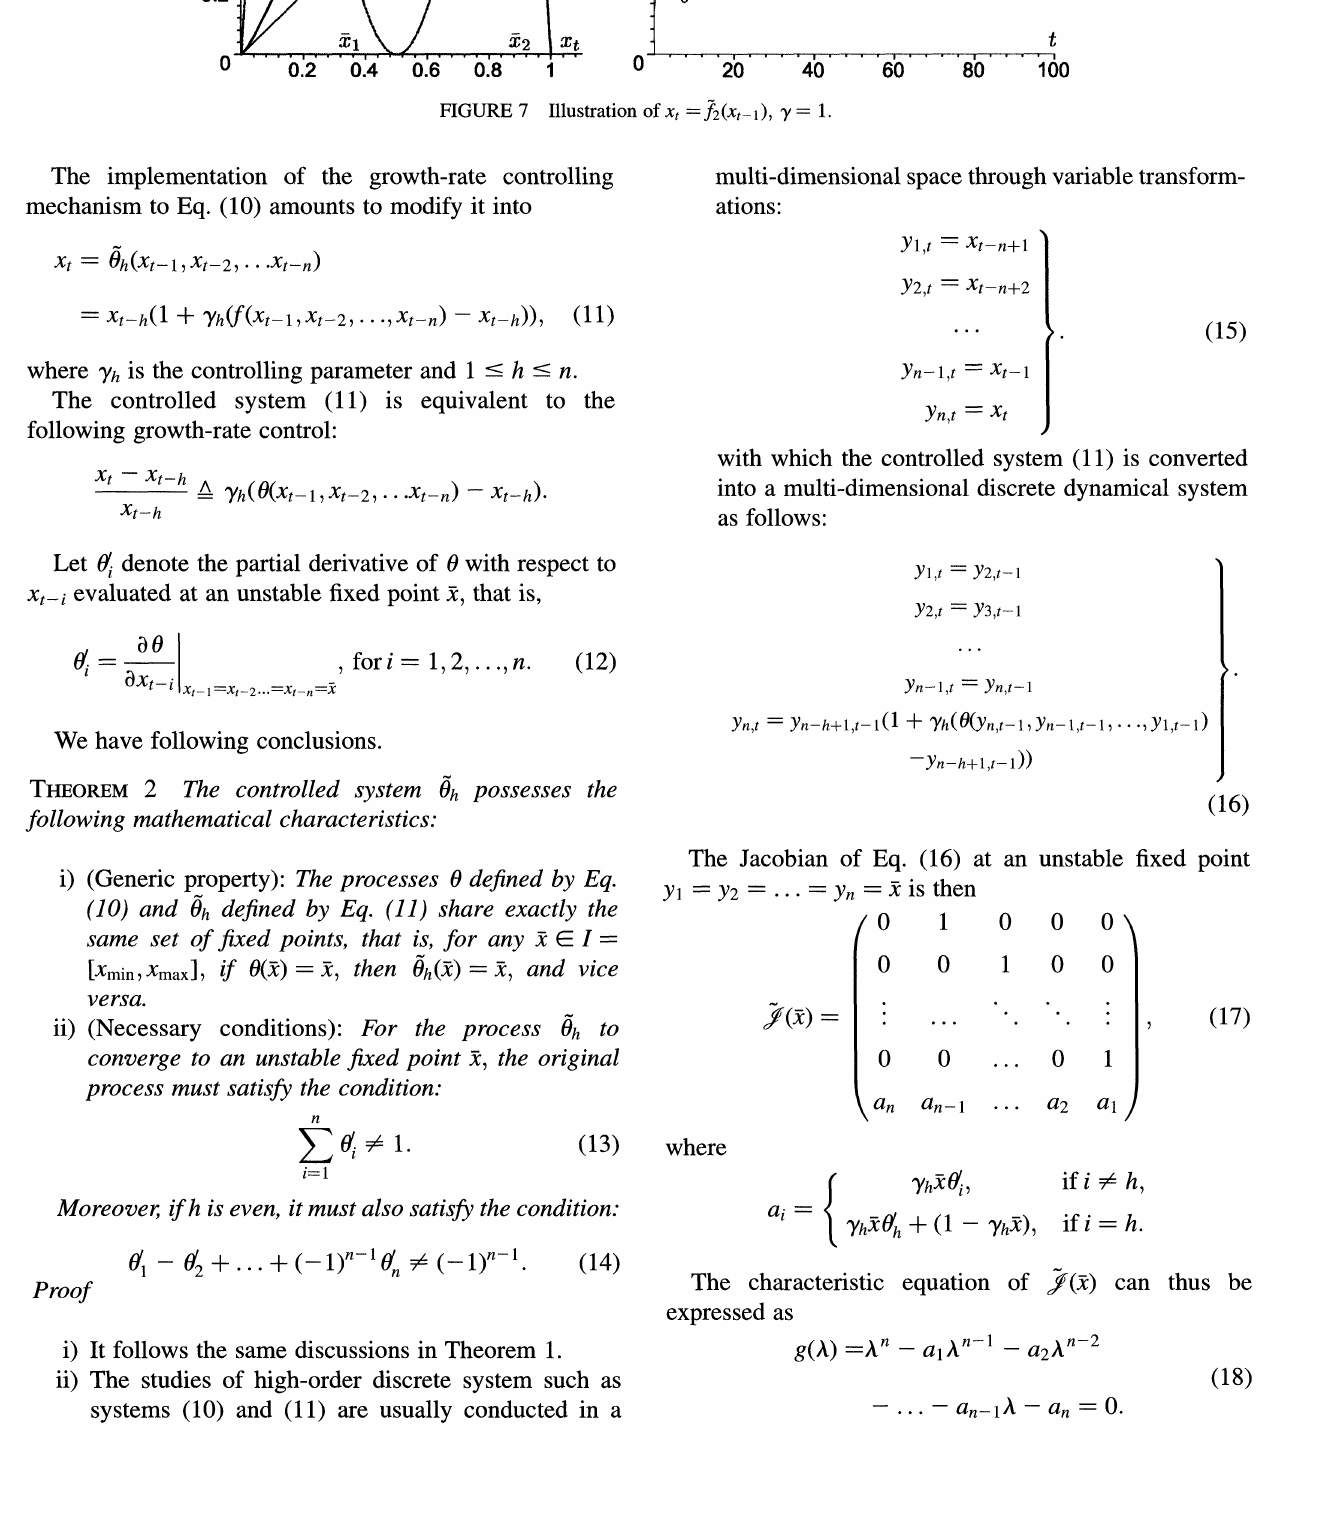
FIGURE 7 Illustration of xt =j2(xt-1), y=